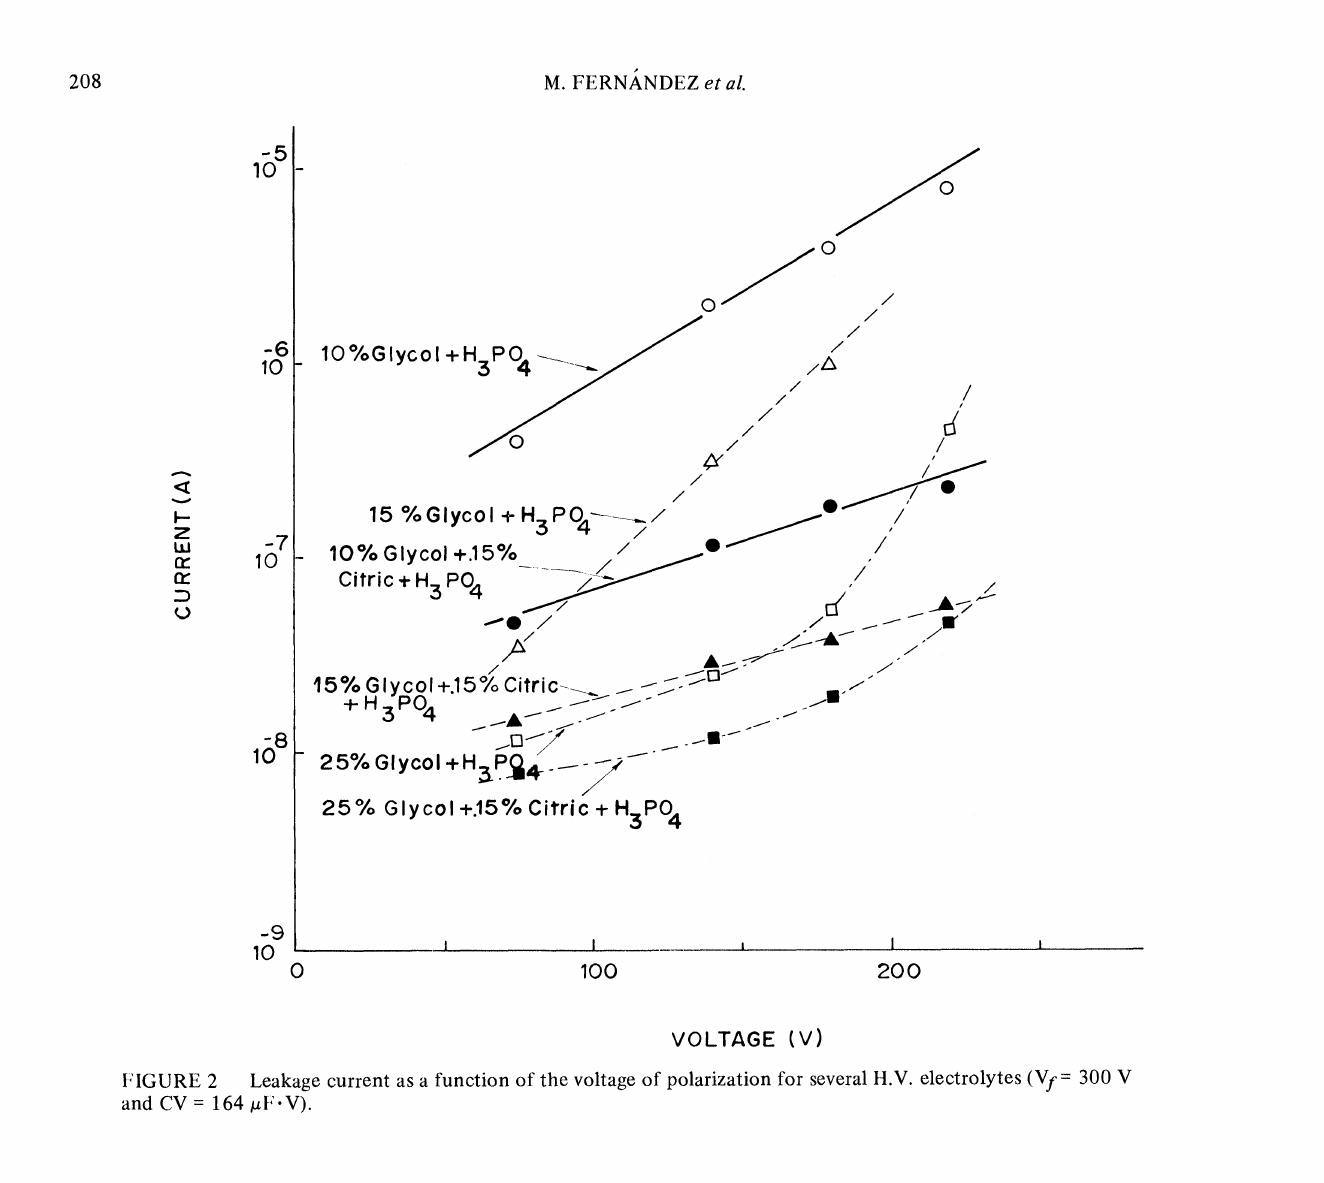
Leakage current as a function of the voltage of polarization for several N.Y. electrolytes (Mr 300 V and CV 164 uF"